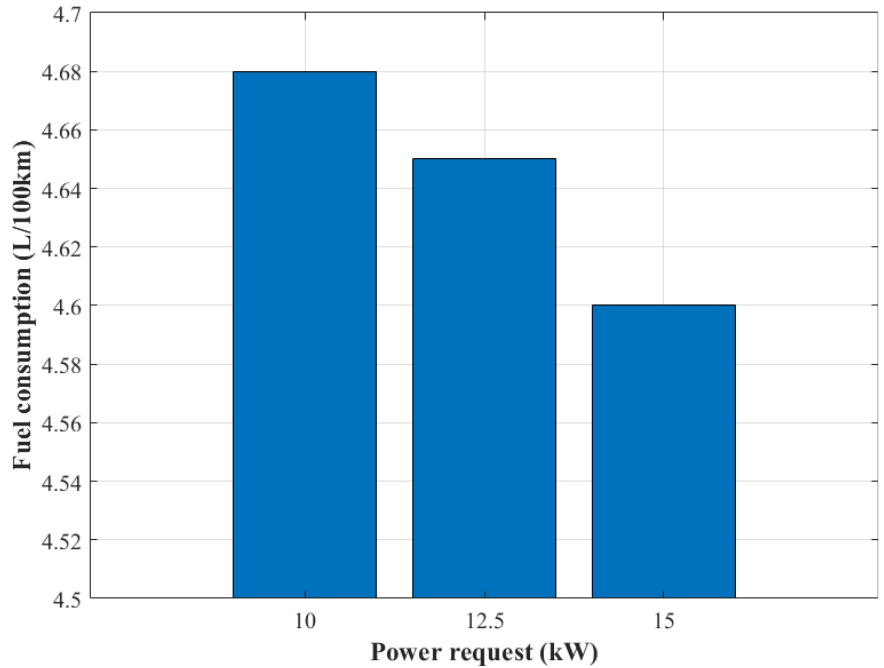
Figure 8. Fuel comparison on NEDC drive cycle according to the power request.